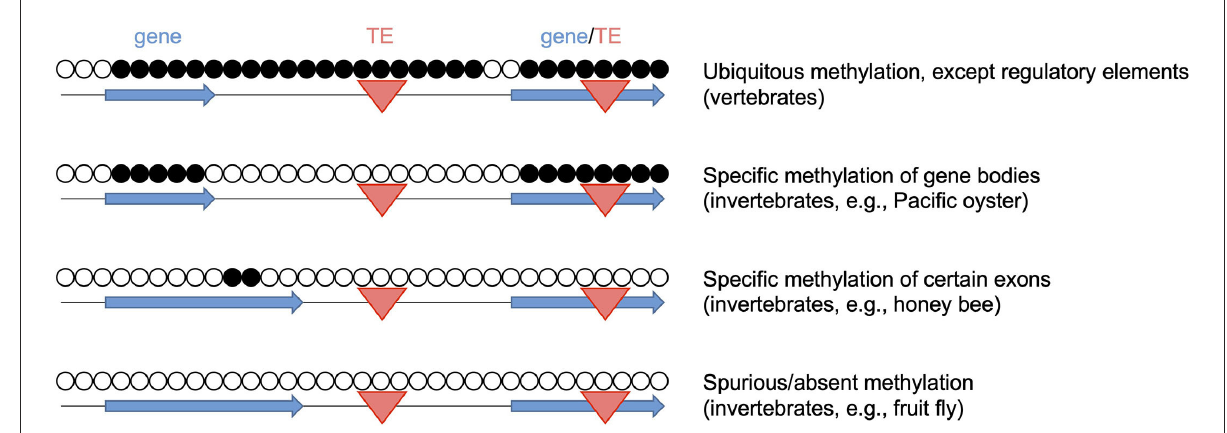
FIGURE1 Diversity of DNA methylation patterns across the animal kingdom. Open and closed circles represent unmethylated and methylated CpGs, respectively. Blue horizontal arrows: gene bodies, red triangles: transposable elements (TE). The representative methylomes are the Pacific oyster (24), the honey bee (25) and the fruit fly